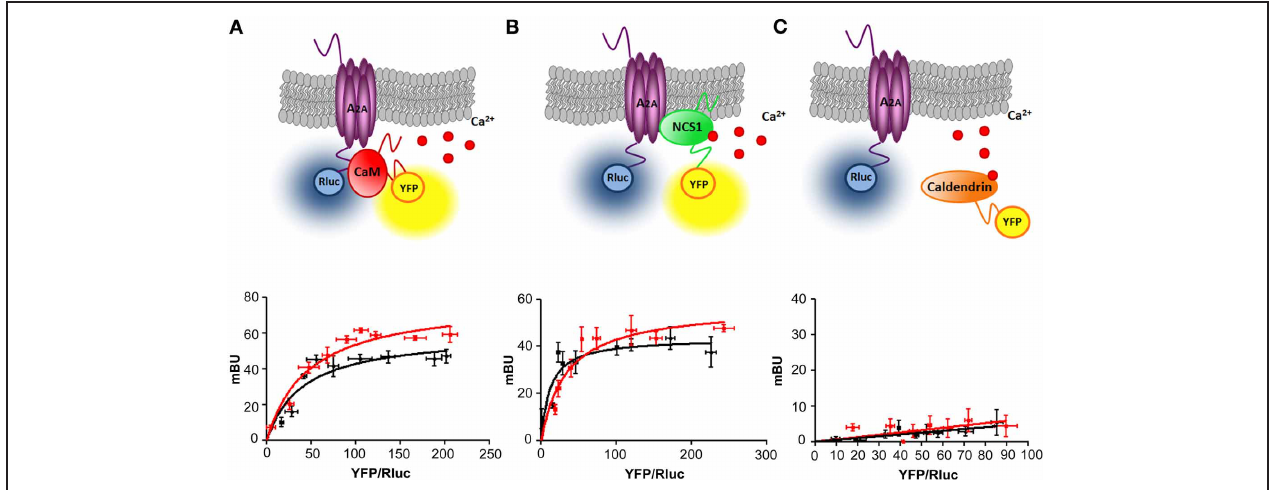
FIGURE 1 | Adenosine A 2A receptors interact with calmodulin and NCS-1 but not with caldendrin. BRET measurements were performed in HEK-293T cells co-transfected with 0.2 μ g cDNA corresponding to the donor